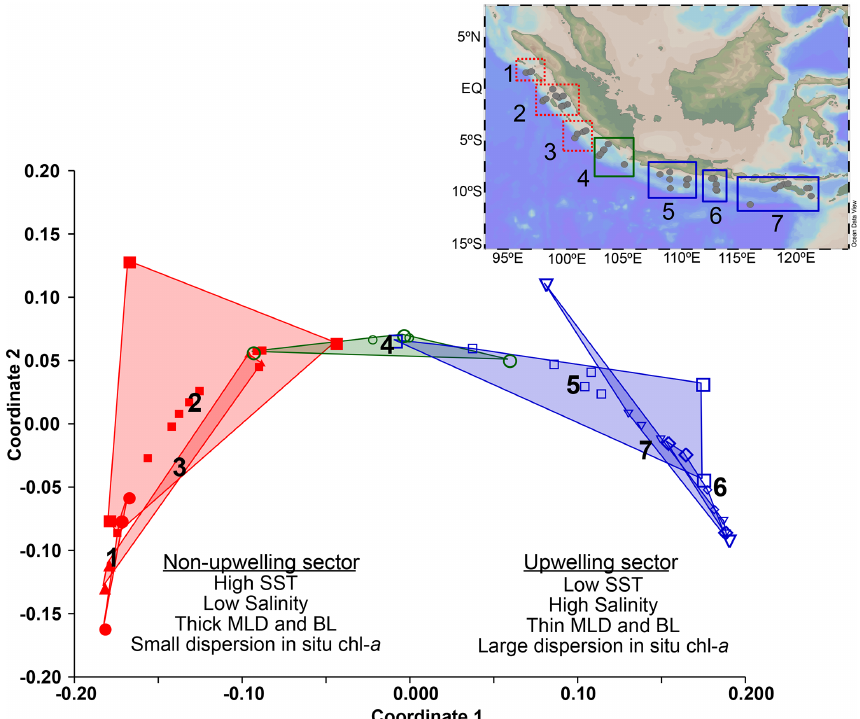
Figure 3. Non-metric multidimensional scaling of the in situ hydrographic parameters shows three main clusters. Cluster 1 includes tran- sects 5 to 7 off Java and the LSI influenced by upwelling (upwelling; blue). Cluster 3 includes transects 1 to 3 located off Sumatra which are not influenced by upwelling (non-upwelling; red). Cluster 2 consists of only transect 4, which represents a transitional condition between Sumatra and Java–LSI (green). Locations of the stations are shown in the inset at the top right corner of the